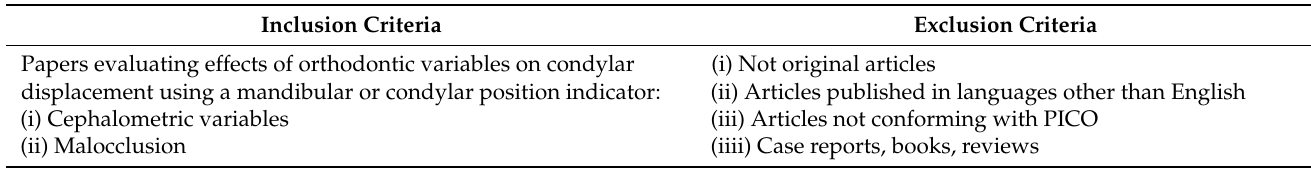
Table 1. Inclusion and exclusion criteria.